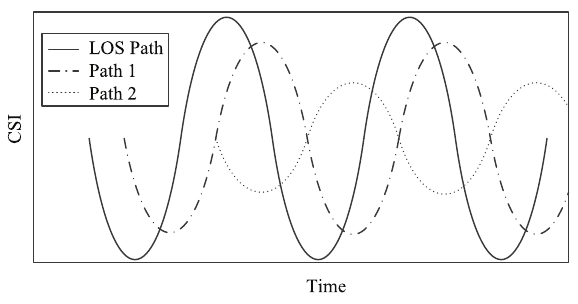
Figure 2. Signal waveform of three propagation